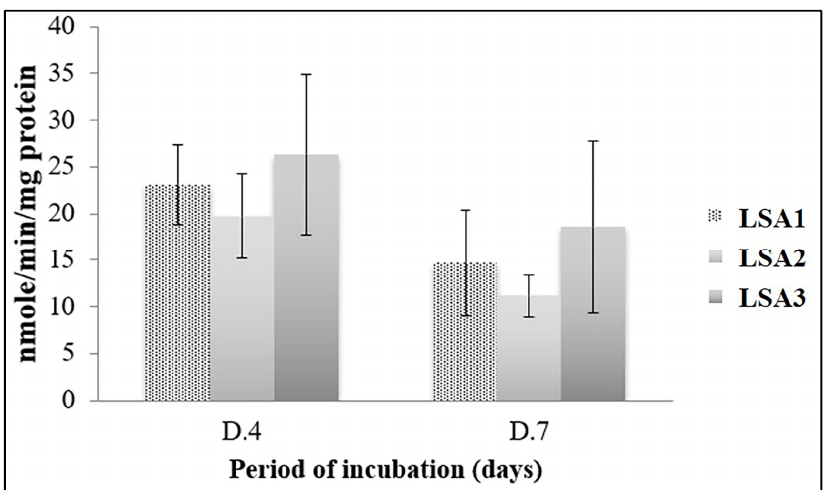
Figure 9. The alkaline phosphatase (ALP) activity. There was no statistical difference among glass- ceramics types and time points.